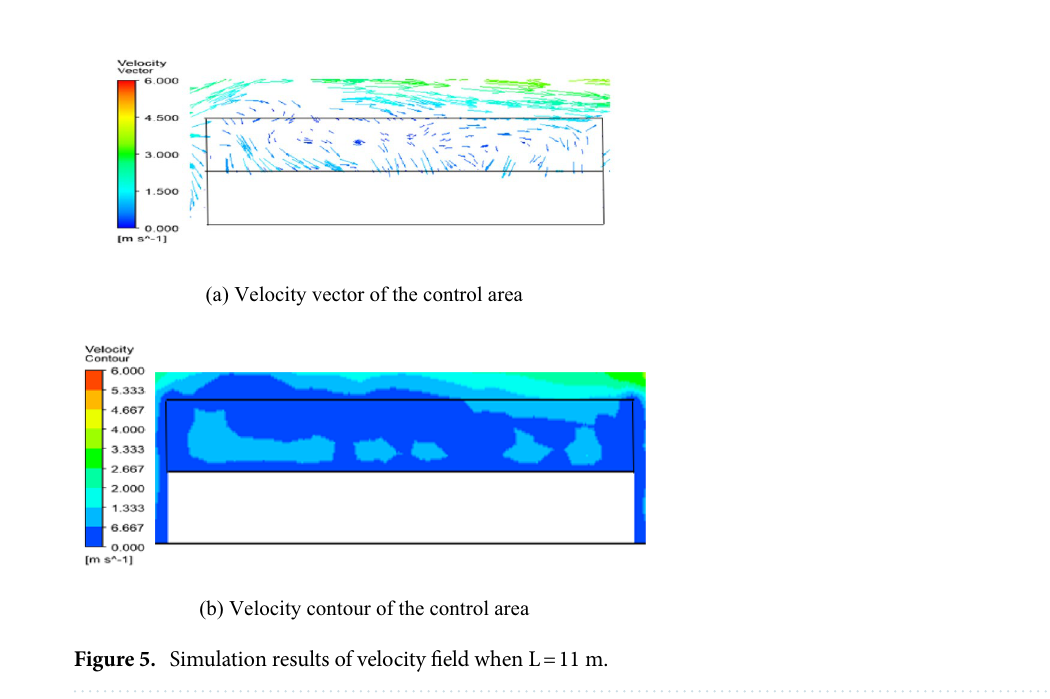
Figure 4. Simulation results of velocity field when L = 6 m.